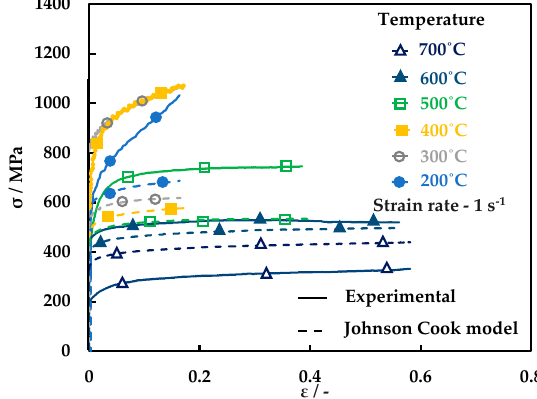
Figure 5. Flow stress curves fitted with J-C model.